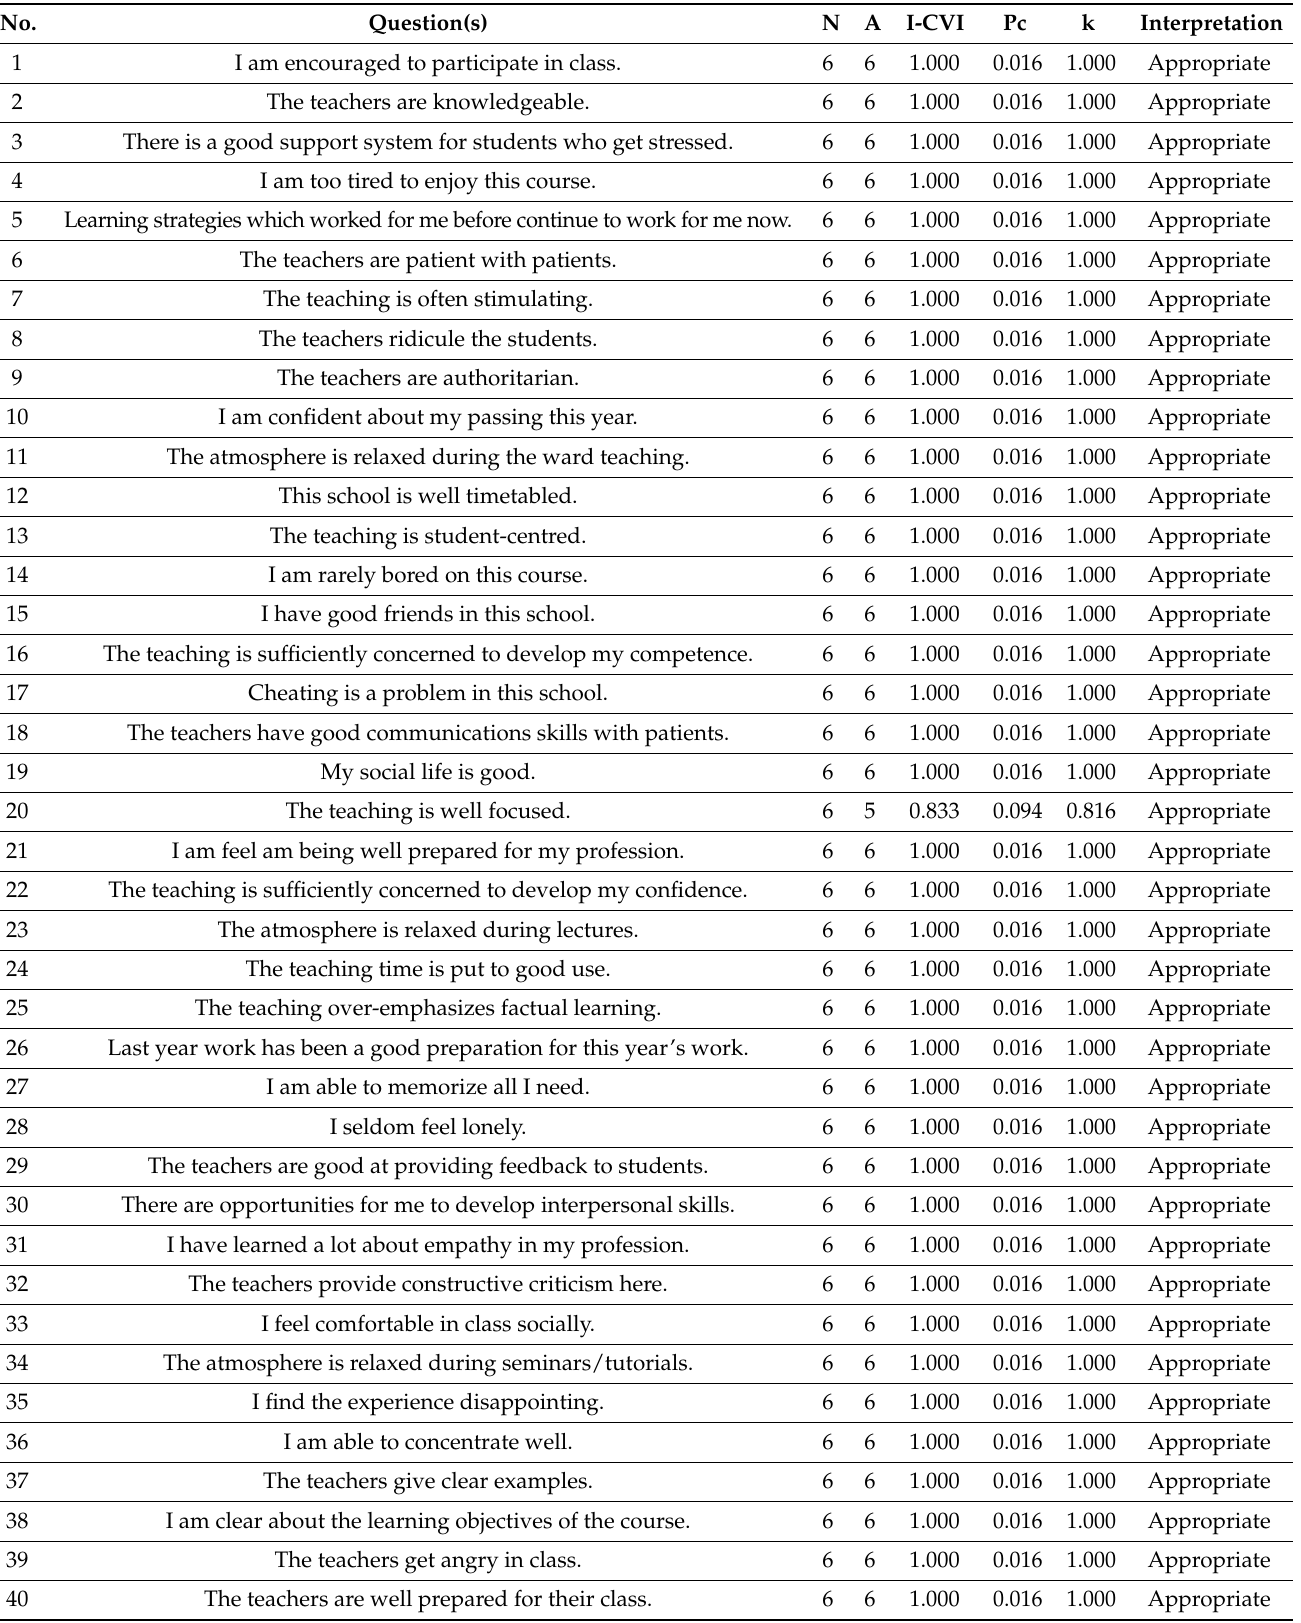
Table 2. Content validity of the DREEM